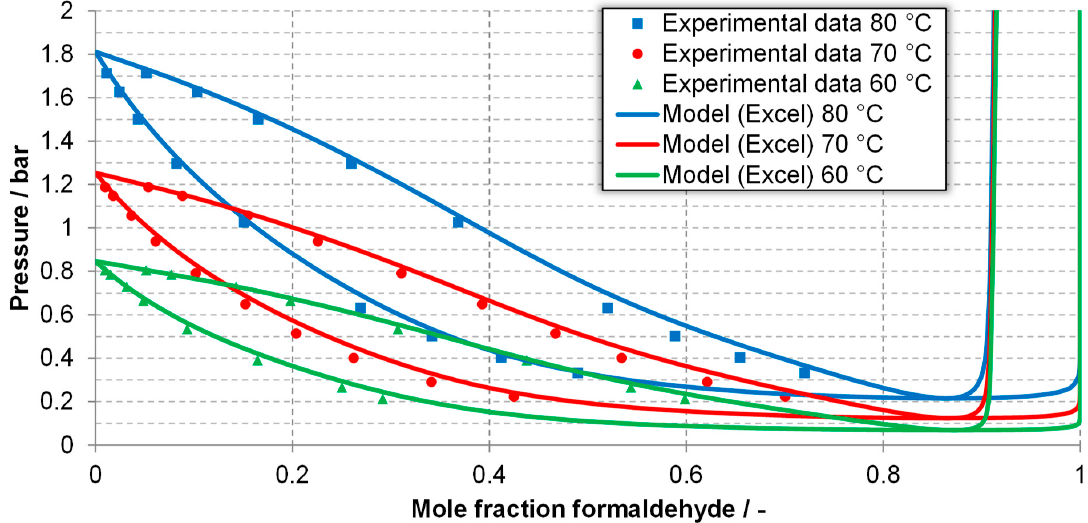
Figure 4. Phase equilibrium of the system formaldehyde-methanol (FA-MeOH) for different temperatures calculated using Excel compared to the experimental data [65].